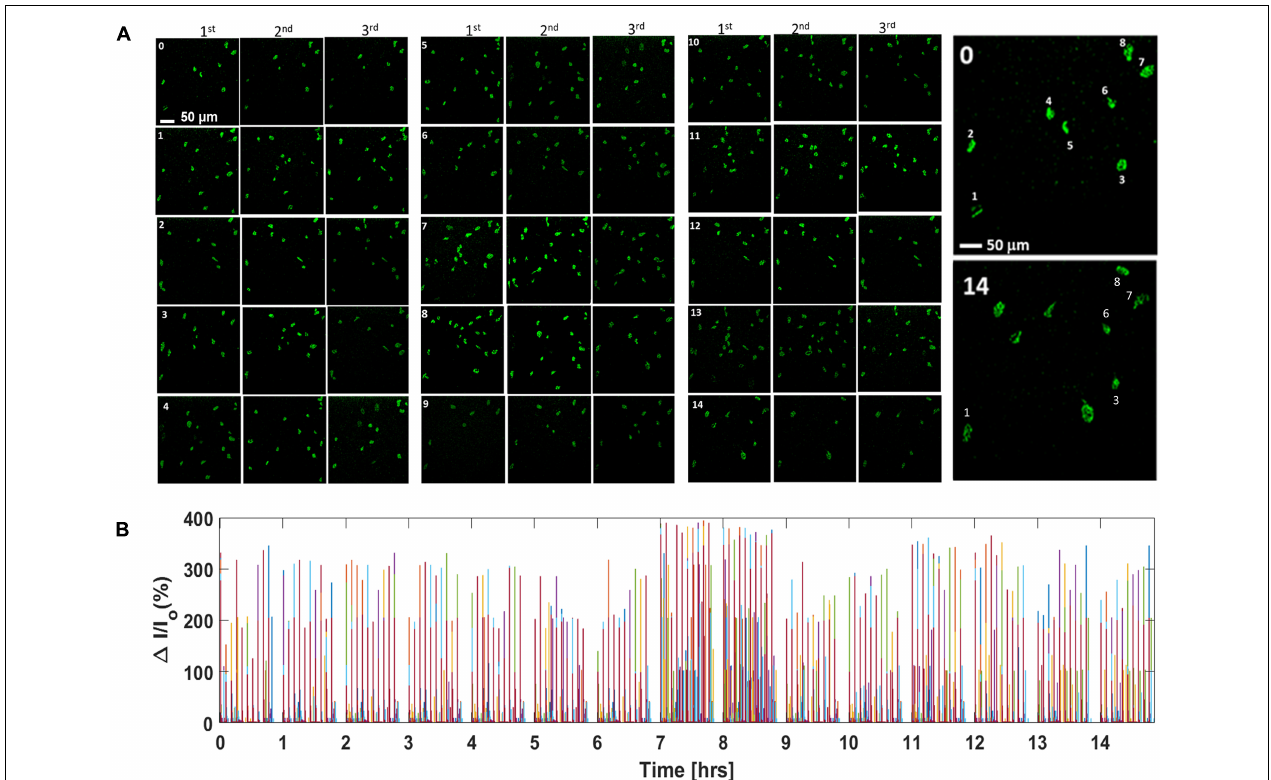
FIGURE 4 | Continuous in vivo visually evoked Ca 2 + bioluminescence activities in the bMCOII-transduced visual cortex of mice for extended duration. (A) Ca 2 + bioluminescence signal after first three consecutive light stimulations at each time point (0–14 h; 0 = 0 h and 14 = 14th h). (B) Continuous plot of light stimulation-induced fractional increase in Ca 2 + bioluminescence signal for the eight assigned active neurons for a 14-h period. Pulse width for light stimulation is 10 ms and intensity is 13 µ W/mm 2 . Activities of different neurons are assigned with different